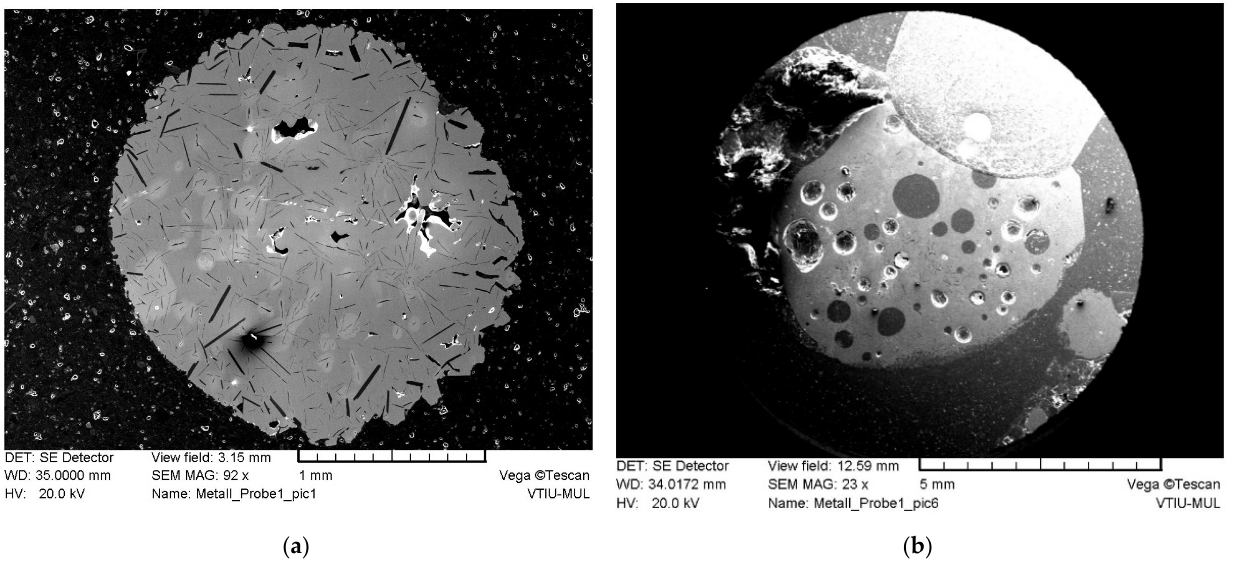
Figure 8. SEM-secondary electron images of cut and polished specimens of the metal-fraction embedded in epoxy resin: ( a ) metal droplet with blowholes and elongated graphite crystallite; ( b ) metal droplet with holes and spherical inclusions.